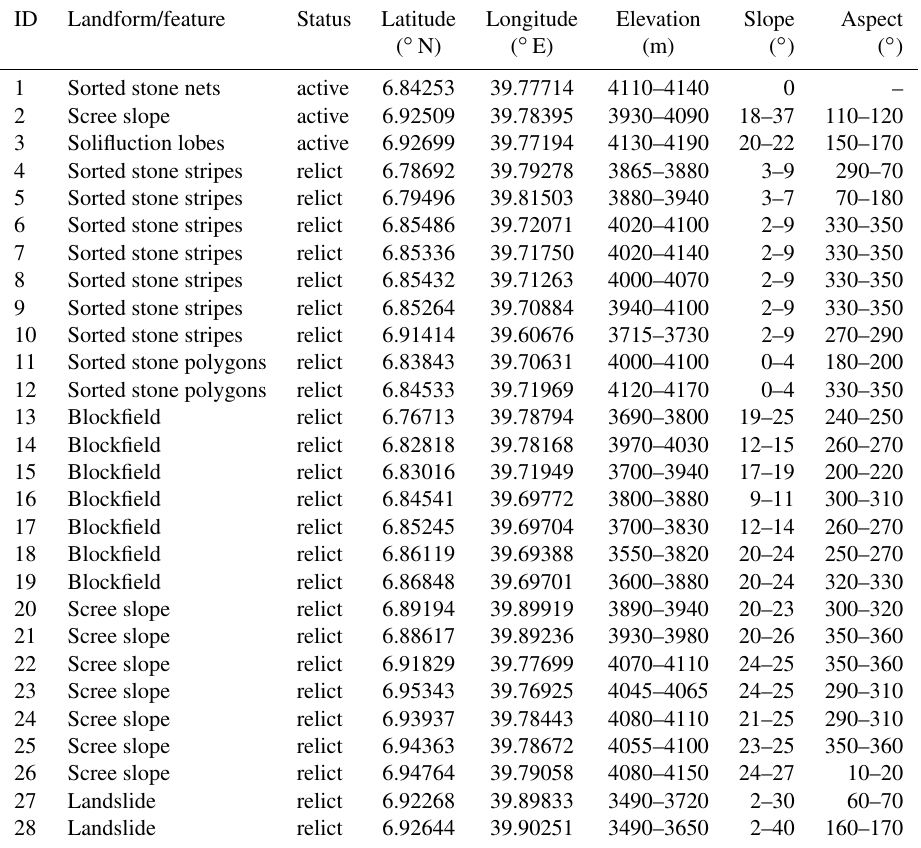
Table A1. Overview of periglacial landforms and other characteristic geomorphological features in the Bale Mountains mapped in the field and on satellite images. A compilation of glacial landforms in the Bale Mountains is provided by Groos et al. (2021).